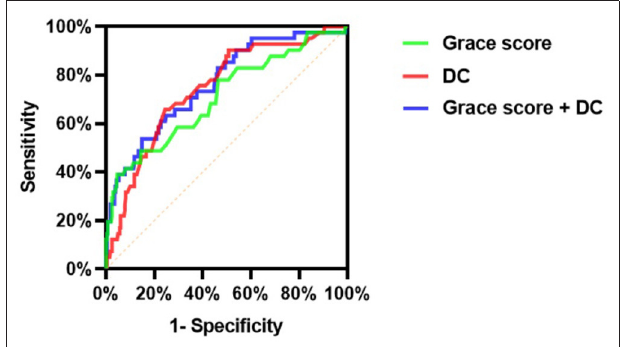
FIGURE 3 | Comparison of discrimination and reclassification abilities of predictive models for MACEs (Model 1: Grace score; Model 2: DC; Model 3: Grace score + DC).